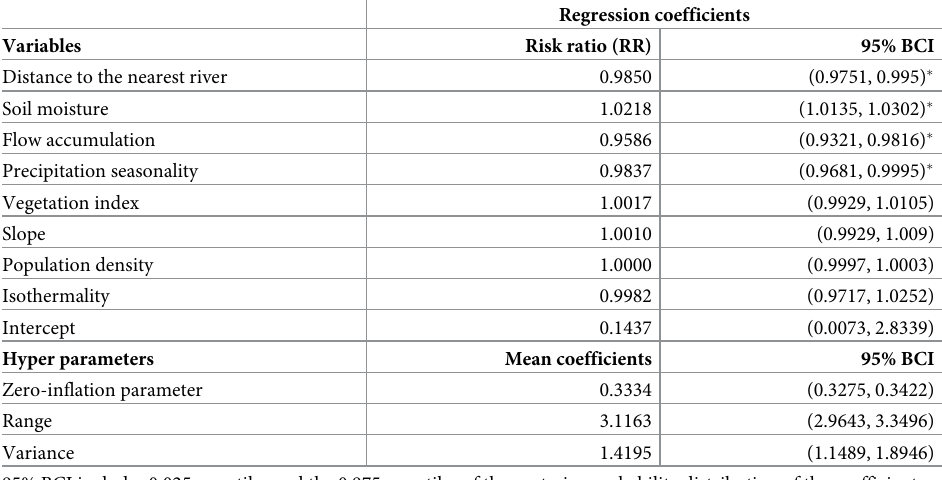
Table 1. Mean coefficient estimates and 95% Bayesian credible interval (BCI) for the environmental and socio- demographic variables in the model. Regression coefficients for covariates are presented as a risk ratio (RR), which represents the change in prevalence for a unit change in that covariate given that all other variables are kept constant. Significant covariates are followed by an asterisk ( �